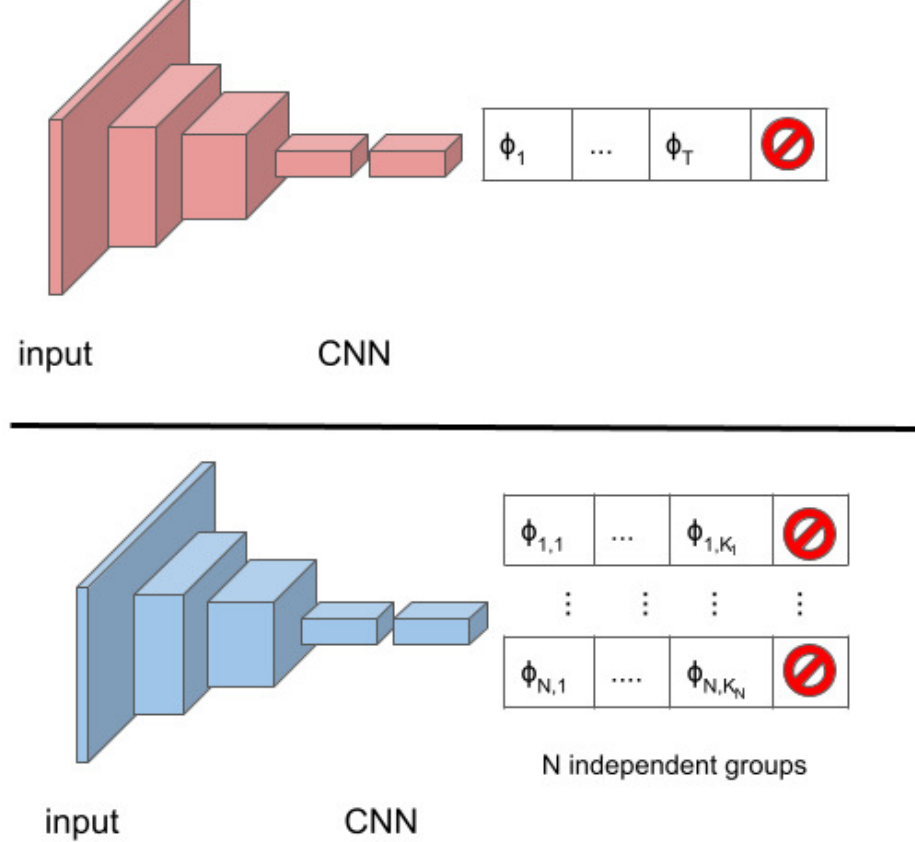
Figure 3. On the top, the model estimates the probability distribution over all the transformations. On the bottom, the model estimates N probability distributions, one for each group of